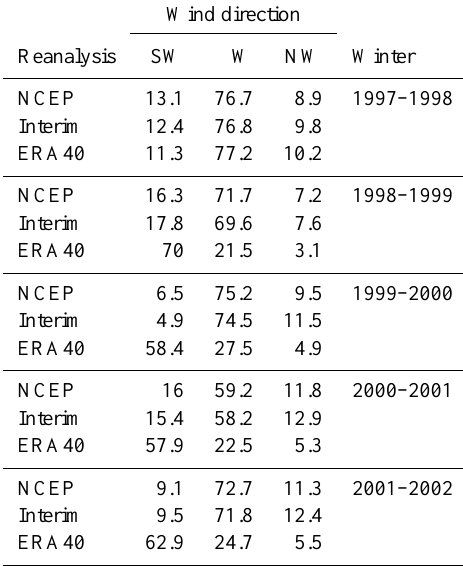
Table 3. Occurrence frequency of wind directions (in percentage) for all three reanalyses for the winters (October–March) of 1997 to 2002 in the European sector (52.5 ◦ N, 0–90 ◦ E).